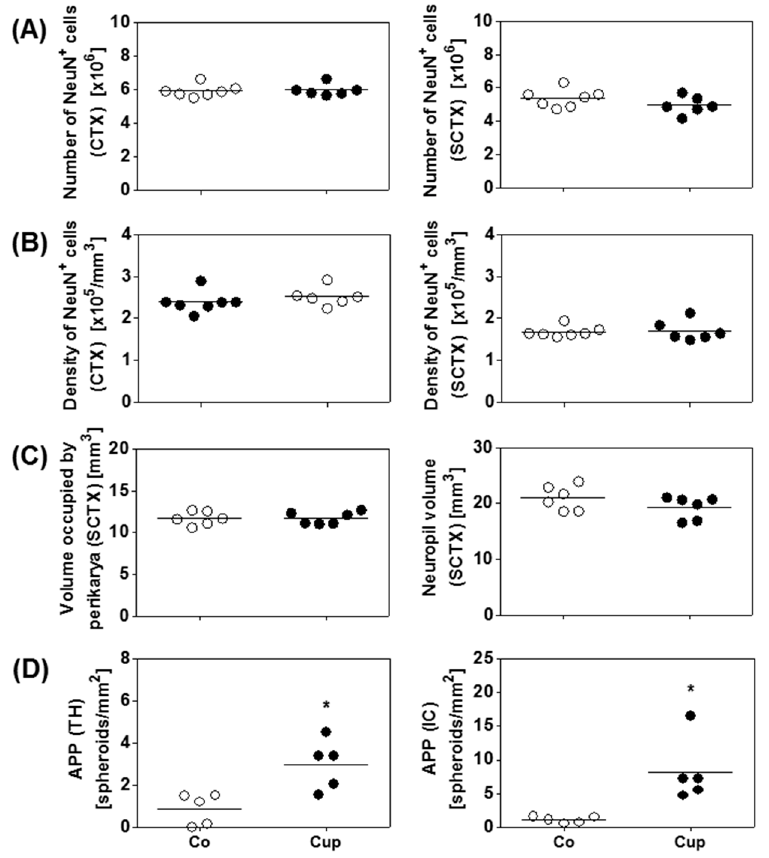
Figure 4. E ff ects of chronic demyelination on the neuro-axonal / -dendritic compartment. ( A ) Numbers and ( B ) densities of neurons in the cerebral cortex (CTX) and the subcortical area (SCTX) of control (Co) ( n = 6) and 12 weeks of cuprizone-intoxicated (Cup) mice ( n = 6) analyzed with design-based stereology. ( C ) Neuropil volumes and volumes occupied by nerve cell perikarya in the SCTX of Co ( n = 6) and 12-week Cup mice ( n = 6). ( D ) Quantification of amyloid precursor protein (APP)-positive spheroids in the thalamus (TH) and internal capsule (IC) of chronically demyelinated mice ( n = 5). Data are shown as individual values and means per group (lines). Statistical analysis revealed significant di ff erences between Co and Cup in ( D ) (TH, p = 0.02; IC, p = 0.02); * p <